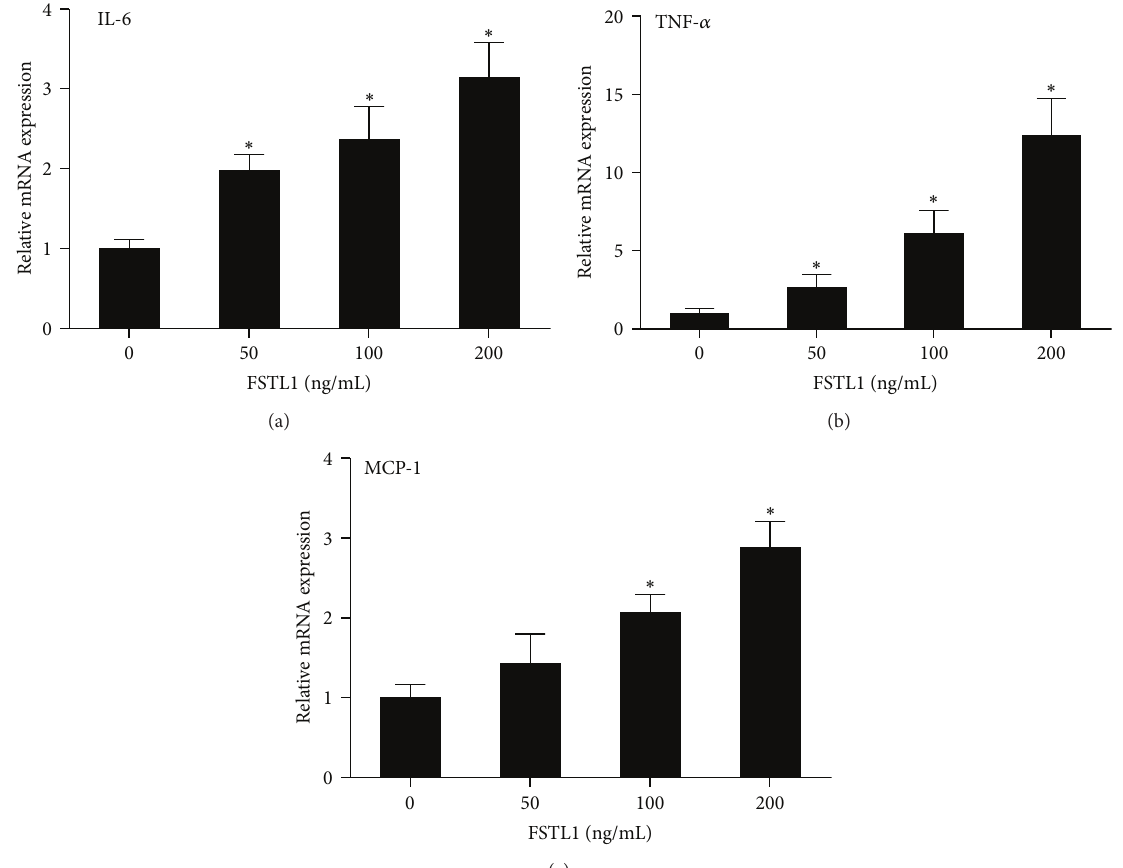
Figure 4: FSTL1 induces the expression of proinflammatory mediators in 3T3-L1 adipocytes. Differentiated 3T3-L1 adipocytes were treated with increasing dose of recombinant mouse FSTL1 (0, 50, 100, and 200 ng/mL) for 24h. mRNA expressions of IL-6 (a), TNF- 𝛼 (b), and MCP-1 (c) were evaluated by quantitative RT-PCR. Relative gene expression levels were normalized to 𝛽 -actin and expressed as fold of control. Data are mean ± SE; 𝑛 = 3 . ∗ 𝑃 < 0.05 versus